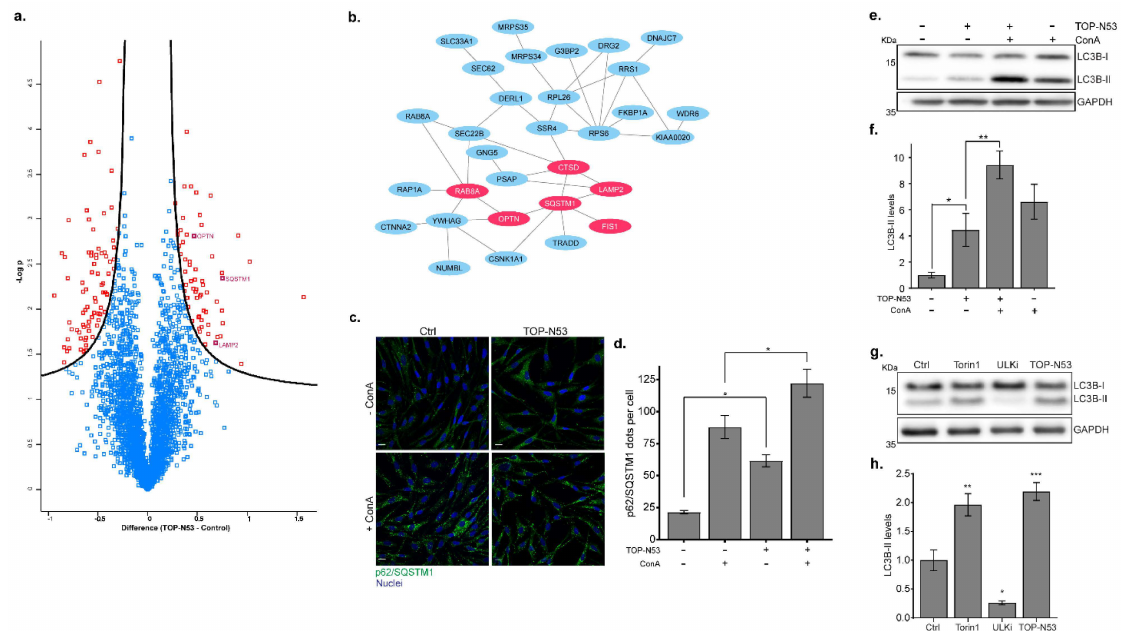
Figure 3. NHFs treated with TOP-N53 exhibit increased autophagic flux. ( a ) Volcano plot highlight- ing significantly regulated proteins. Data were log 2 transformed and significance was tested with two-samples test using a permutation-based FDR ≤ 0.05. Proteins enriched in TOP-N53-treated NHFs are placed on the right side and proteins enriched in control conditions are placed on the left side. Proteins related to autophagy (enriched in TOP-N53 treated NHF), such as SQSTM1/p62, OPTN or LAMP2, are highlighted. Full lists of significantly regulated proteins are shown in Supplementary Tables S6 and S7. ( b ) Network analysis of significantly enriched proteins in TOP-N53- treated NHFs. Protein–protein interactions of 63 significantly enriched proteins in TOP-N53-treated NHF as analyzed by STRING DB (FDR < 0.05). Red-labeled proteins carry terms “autophagy” (GOBP). Only part of the network is presented; the list of proteins and full network is shown in Supplementary Table S6 and Supplementary Figure S2, respectively. ( c ) Immunofluorescence stain- ing of p62. Control and TOP-N53-treated NHFs in presence or not of ConA were stained with anti-p62 antibody (green). Nuclei were stained with Hoechst 33258 (blue). Scale bars, 15 µ m. ( d ) Quantification of p62 puncta. Quantification was performed with Imaris software. Bars represent the mean ± s.e. of the number of p62 puncta per cell in each condition. Between 97 and 127 cells were counted per condition. * p ≤ 0.05 using one-way ANOVA with a Tukey test post-hoc analysis. ( e ) Autophagy flux analysis. To analyze lysosomal activity, autophagy flux was analyzed in control and TOP-N53-treated (1 µ M; 24 h) NHF in presence or not of 2.5 nM ConA. Representative Western blot image and ( f ) quantification of LC3B-II levels are shown. Data were normalized to GAPDH and are represented as mean ± s.e. ( n = 3). * p ≤ 0.05 and ** p ≤ 0.01 using one-way ANOVA with a Holm-Sidak test post-hoc analysis. ( g ) Autophagy activation by TOP-N53 was compared with the induction by the mTORC1 inhibitor Torin-1. NHF were treated with TOP-N53 (1 µ M; 24 h), ULK1 inhibitor MRT68921 (1 µ M; 2 h), and Torin-1 (1 µ M; 2 h). ConA was added in all cases for the last 2 h of treatment. Representative Western blot images and ( h ) quantification of LC3B-II levels are shown. Data were normalized to GAPDH and are represented as mean ± s.e. ( n = 3). * p ≤ 0.05 and ** p ≤ 0.01, *** p ≤ 0.001 using one-way ANOVA with a Holm–Sidak test post-hoc